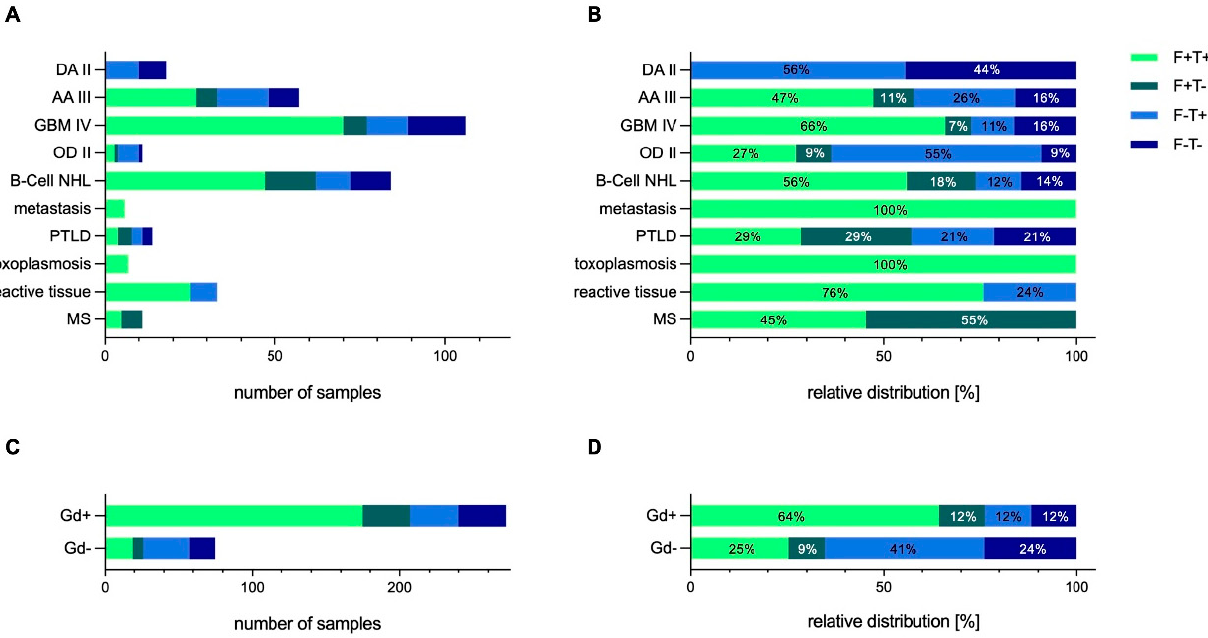
Figure 2. Fluorescein uptake patterns based on pathology and Gadolinium (Gd)-enhancement. ( A , B ) Distribution of Fluorescein uptake and diagnostic yield based on pathology. ( C , D ) Fluorescein uptake and diagnostic yield depending on Gadolinium uptake on MRI. Samples were categorized in four categories: (1) fluorescein-positive and tumor/tissue diagnosis positive (F+T+), (2) fluorescein-positive and tumor/tissue diagnosis negative (F+T-), (3) fluorescein-negative and tumor/tissue diagnosis positive (F-T+), (4) fluorescein-negative and tumor/tissue diagnosis negative (F-T-). Abbreviations: DA II = diffuse astrocytoma; IDH-mutant WHO grade II; AA III = anaplastic astrocytoma; IDH-mutant WHO grade III; B-Cell NHL = B-cell non-Hodgkin lymphoma; GBM IV = glioblastoma WHO grade IV; Gd = gadolinium; MS = multiple sclerosis; OD II = oligodendroglioma; IDH-mutant and 1p/19q-codeleted WHO grade II; PTLD = post transplantation lymphoproliferative disorder.